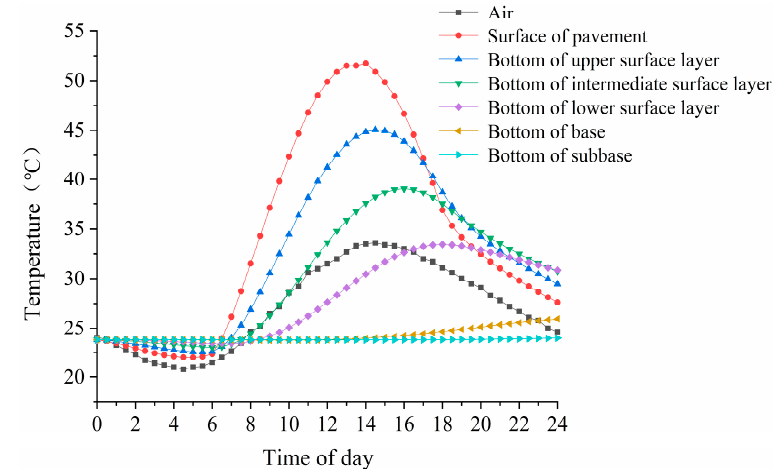
Figure 6. Temperature variation of each structural layer of pavement during 24 h of 1 day.